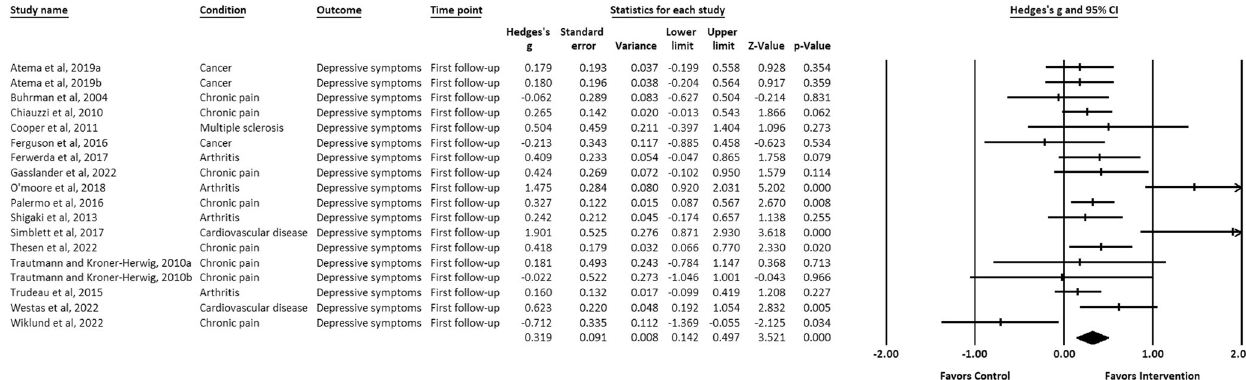
Fig. 5 Forest plot for effect sizes of IM-CBT on depressive symptoms at fi rst follow-up.